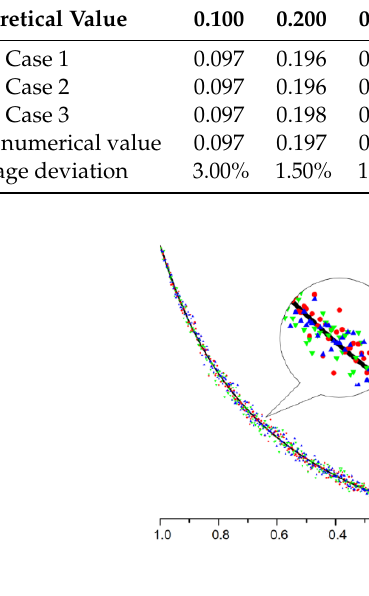
Figure 3. The s i obtained in PFC model when S c is 0.3.